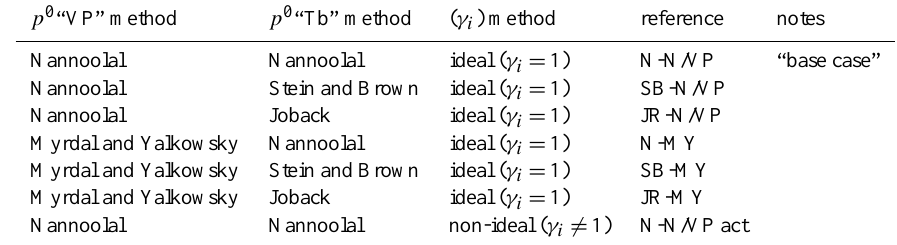
Table 2. Combinations of ( p 0 ) and ( γ i ) predictive techniques used within absorptive partitioning